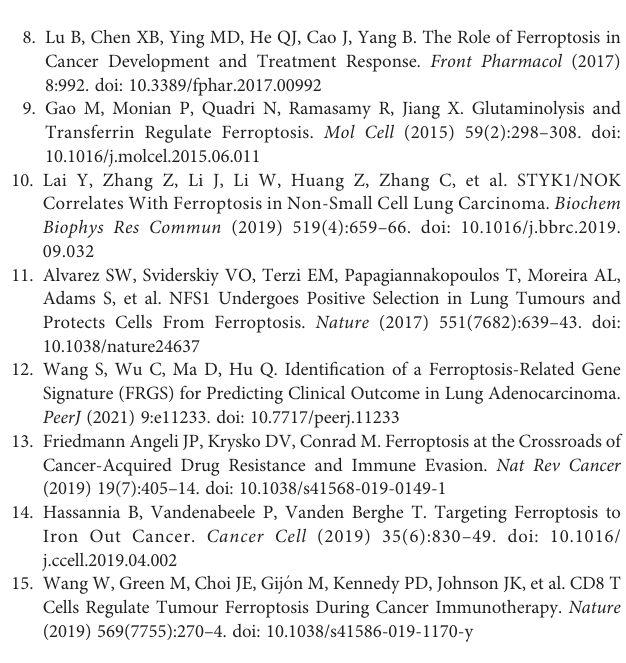
Supplementary Figure 9 | Survival analysis of early-stage LUAD patients harboring EGFR or KRAS mutation in GSE31210 cohort. Kaplan-Meier curves of overall survival in EGFR-WT (A) , EGFR-Mut (B) , KRAS-WT (C) , KRAS-Mut (D) and EGFR/KRAS-WT (E) patients based on FRGscore. Supplementary Figure 10 | Independent prognostic value of FRGscore. (A, B) Univariate (A) and multivariate (B) Cox analyses of recurrence-free survival based on FRGscore in TCGA cohort. (C – D) Univariate (C) and multivariate (D) Cox analyses of overall survival based on FRGscore in TCGA cohort. (E-F) Univariate (E) and multivariate (F) Cox analyses of recurrence-free survival based on FRGscore in GSE31210 cohort. (G, H) Univariate (G) and multivariate (H) Cox analyses of overall survival based on FRGscore in GSE31210 cohort. Supplementary Figure 11 | Meta-analysis of prognostic values of FRG signatures in early-stage LUAD patients across the four cohorts. P-values of TCGA (n=369) , GSE31210 (n=226) , GSE68465 (n=363) and GSE50081 (n=127) were calculated by Kaplan-Meier curves. P-value of overall (n=1085) patients was calculated by meta-analysis. Supplementary Figure 12 | Biological pathways associated with FRGscore-high and FRGscore-low subgroups. Supplementary Figure13 | Genetic alterationof the identi fi ed11 FRG signatures in TCGA-LUAD cohort. Supplementary Table 1 | Clinical characteristics of patients with early-stage lung adenocarcinoma in the four datasets. Supplementary Table 2 | Data information used in this study. Supplementary Table 3 | FRG signature genes (A, B)